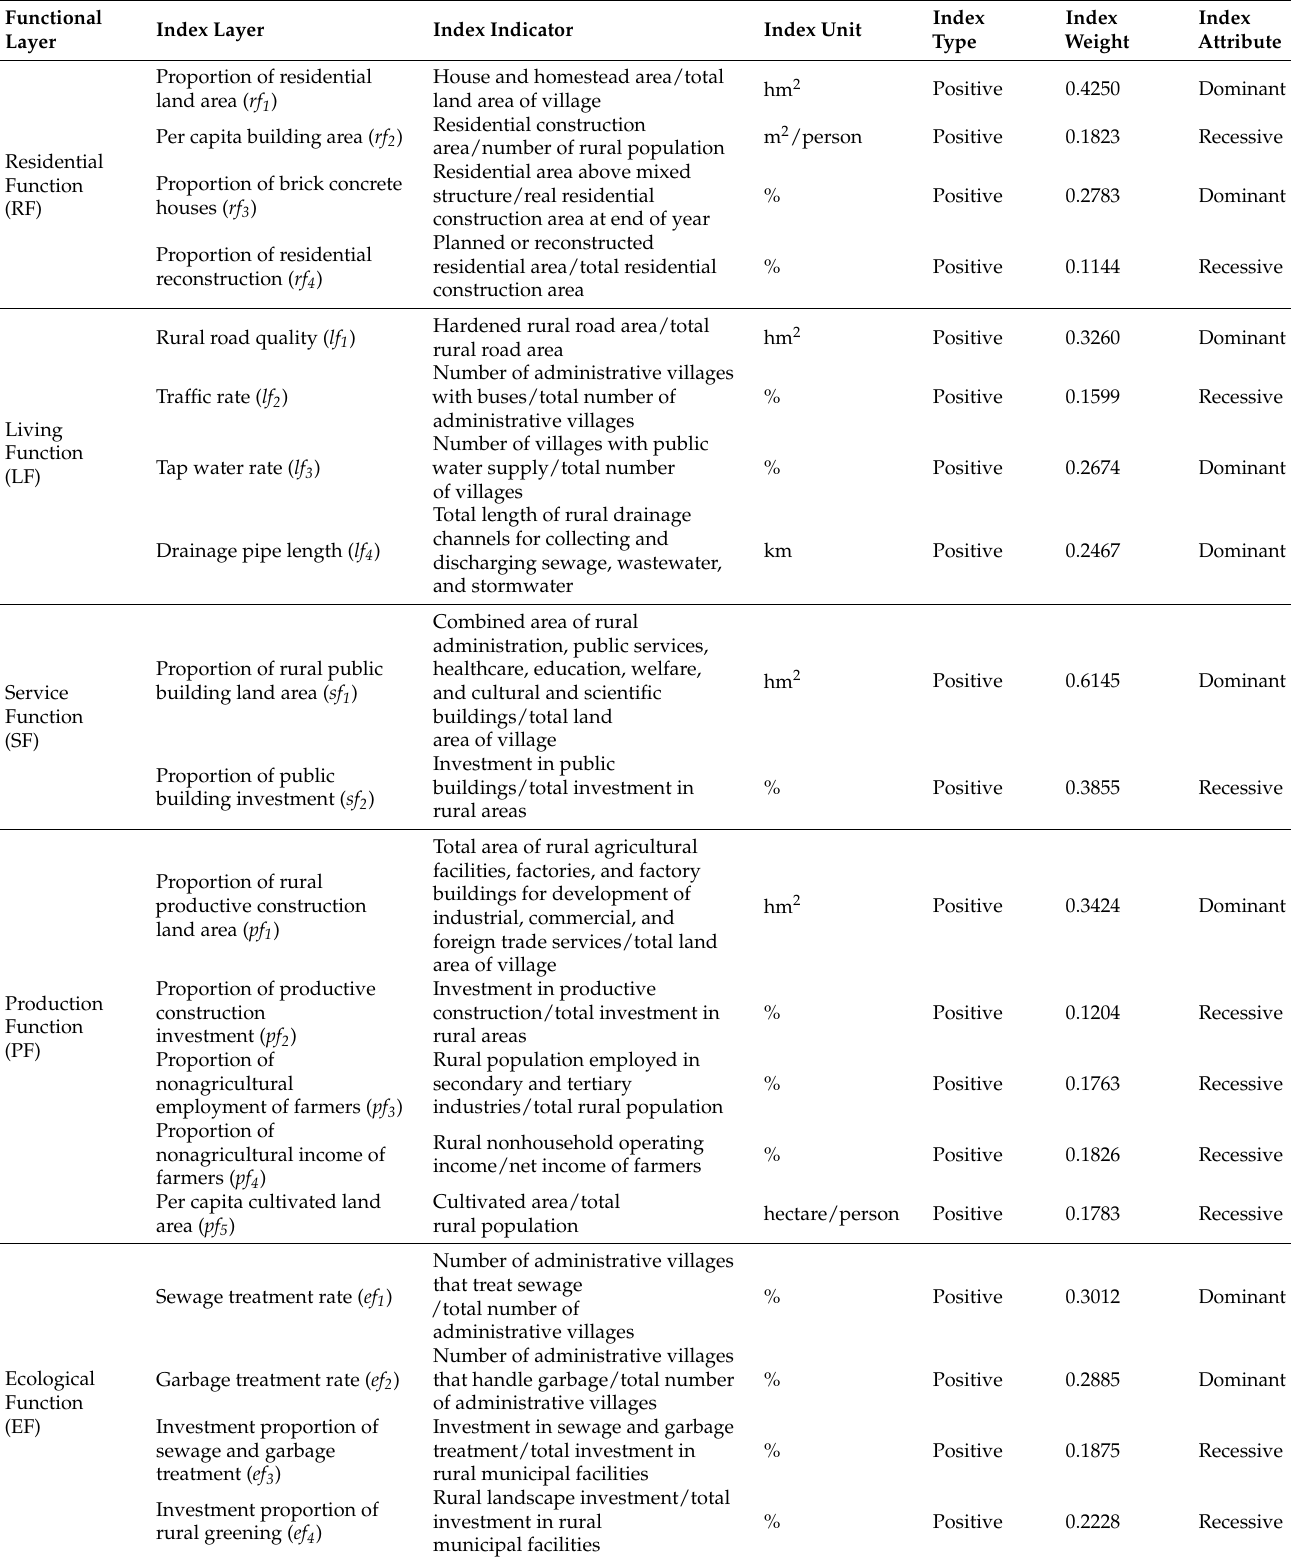
Table 1. Multifunction evaluation index system for rural residential